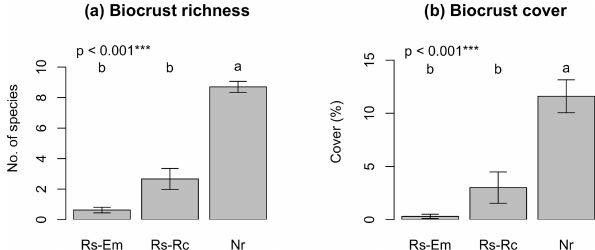
Figure 2. Average values ( ± SE) for biocrust richness and cover. Rs-Em: embankments; Rs-Rc: roadcuts; Nr: natural remnants. For each graph the significance value of the Kruskal–Wallis test is given. Different letters indicate significant differences (Conover– Iman test for post hoc comparisons, p < 0 . 05) among environmen- tal